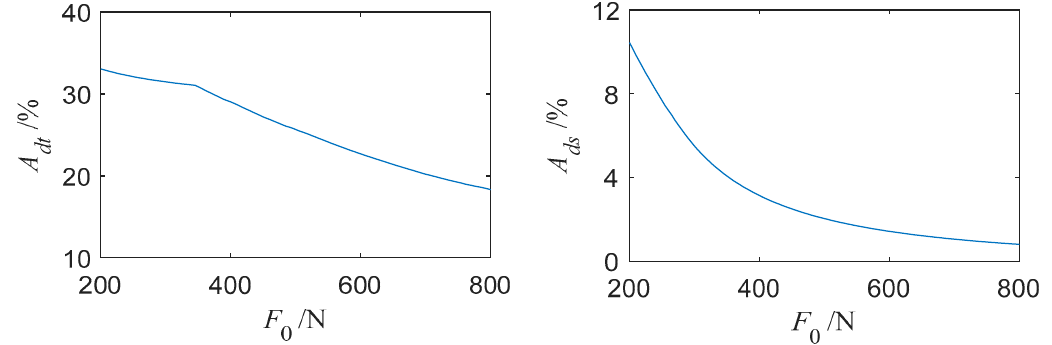
Figure 16. The influence of external excitation amplitude on the reduction of the maximum absolute value of vibrational response.